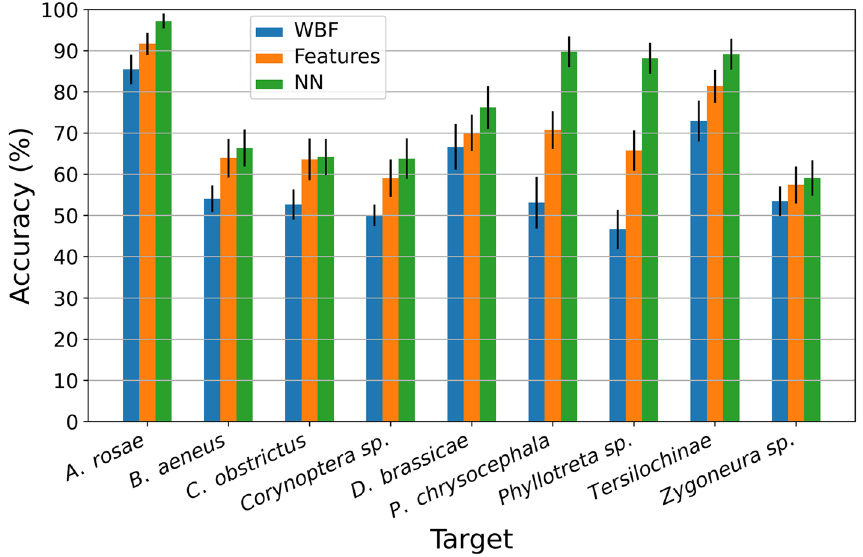
Figure 2. Median classification accuracy (y axis) of one target insect species (x axis) against the most difficult other species (that yielded the lowest average accuracy of 100 repetitions with randomly selected records). Thus, these are the lowest accuracies possible in this study. The error bars show the 90% bootstrapping